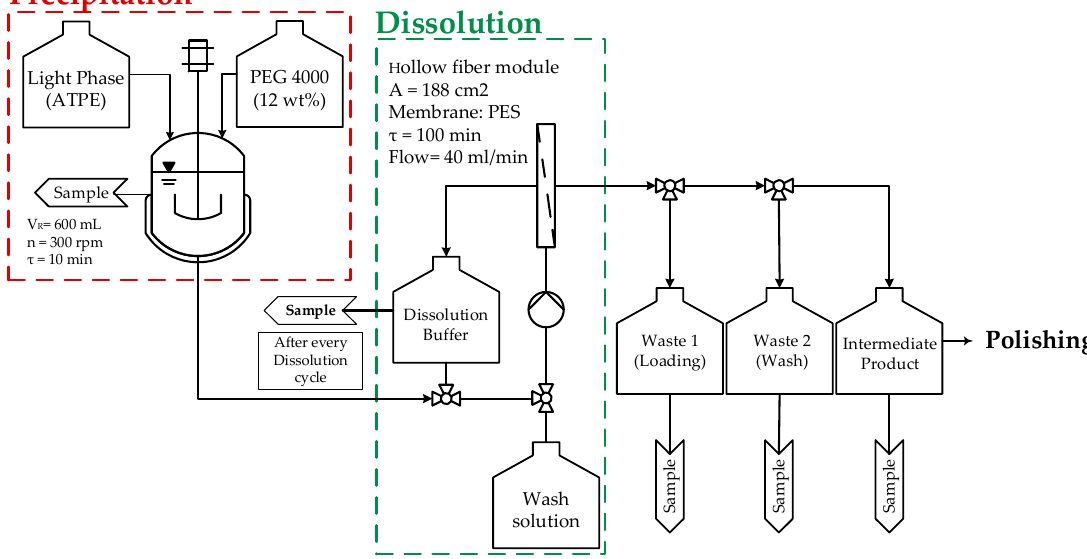
Figure 4. Experimental setup of precipitation unit using a hollow fiber module to capture mAb precipitates and subsequently using IEX buffer for dissolution as a preparation for the next downstream purification step.